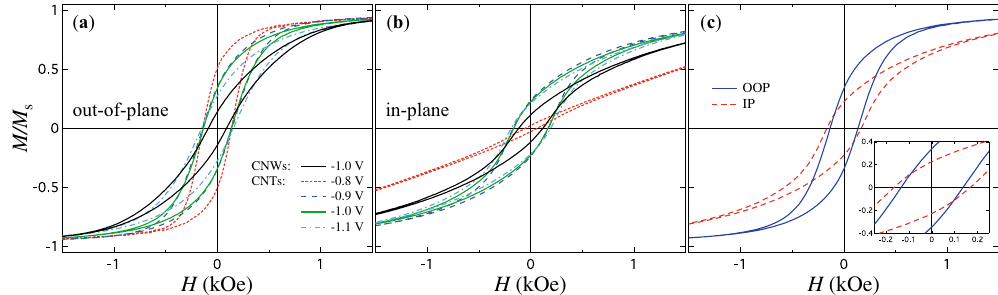
Figure 3. ( a ) Hysteresis loops measured with the magnetic field applied along the out-of-plane (OOP) direction of the PC template for CNT networks ( φ = 230 nm) grown at reduction potentials of − 1.1, − 1.0, − 0.9 and − 0.8 V and Cu oxidation potential of 0.2 V. The hysteresis loop for a Ni CNW network with φ = 230 nm (black continuous line) electrodeposited at − 1.0 V is added for comparison. ( b ) Corresponding hysteresis loops for the samples in ( a ) measured with the magnetic field applied along the in-plane (IP) direction of the PC template. ( c ) Comparison between the hysteresis loops measured in the OOP and IP directions for the CNT network fabricated at a deposition potential of − 1 V. The inset shows a close view of the same figure at low field